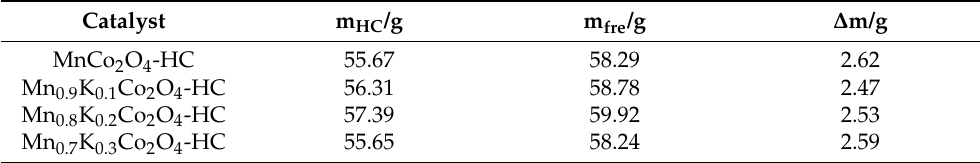
Table 5. The weights of monolith Mn 1 − n K n Co 2 O 4 -HC catalysts and blank honeycomb ceramics (HC).